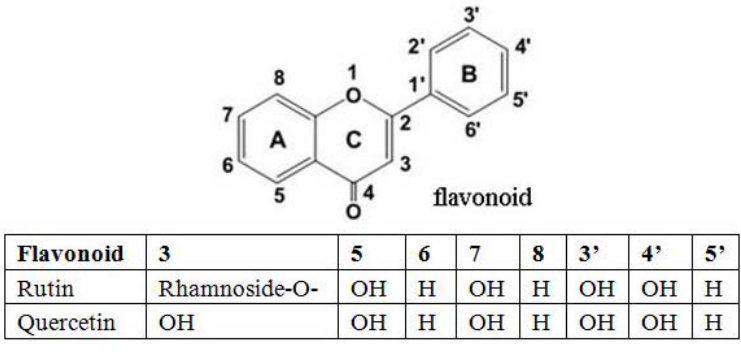
Figure 8. The structures of rutin and